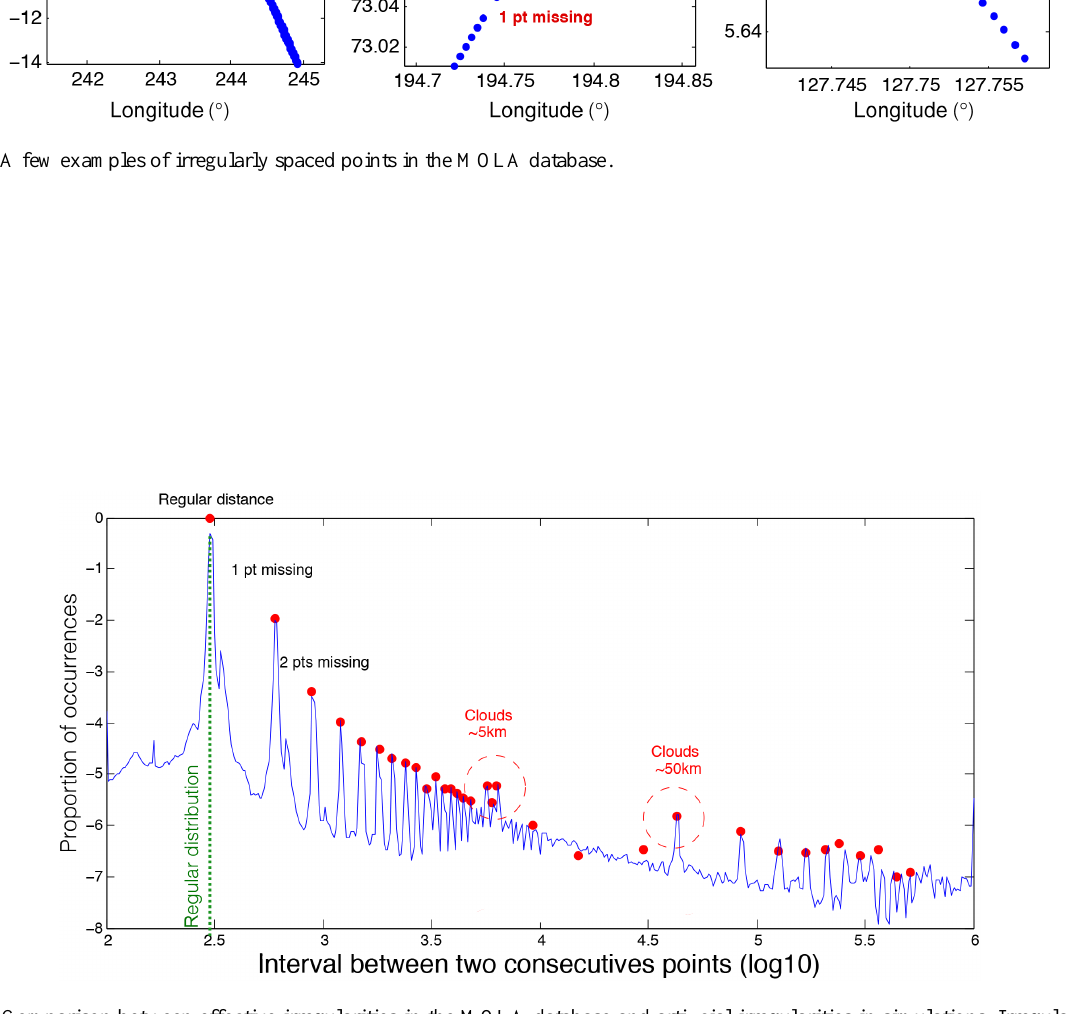
Figure A2. Comparison between effective irregularities in the MOLA database and artificial irregularities in simulations. Irregularities are expressed as a proportion of occurrences from the maximum possible in log10 space (0 means all fluctuations are observed). The blue line represents the effective irregularity of actual data. Red points are obtained from the synthetic irregularities in multifractal simulations. The good agreement between maxima of the blue curve and red points indicates that effective irregularity is accurately reproduced by